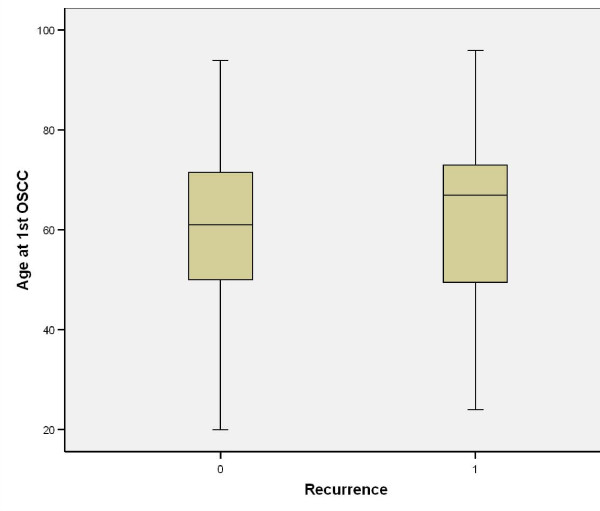
Age at 1st SCC vs. recurrence.